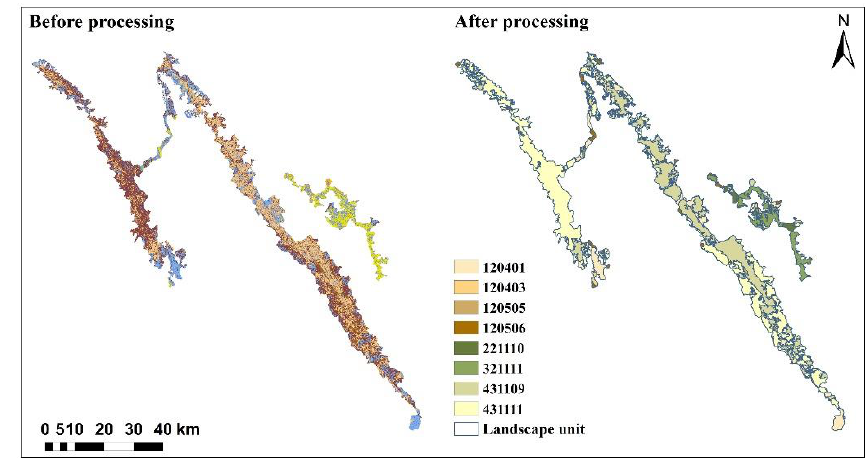
Figure 3. Landscape unit map for the proposed AWNP. Table 1. Landscape unit attribute coding.